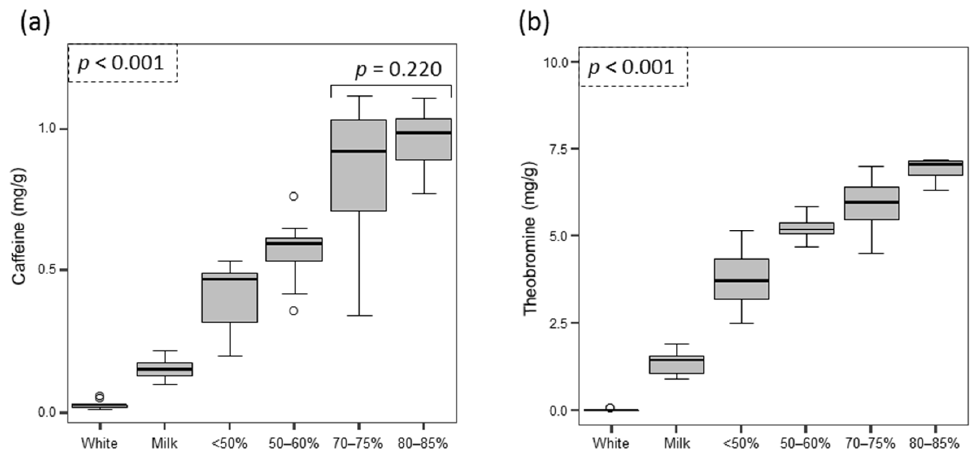
Figure 2. Box ‐ plot displaying the distribution of the concentrations (in mg/g) of caffeine ( a ) and theobromine ( b ) detected in the different types of chocolate foods analyzed. theobromine ( b ) detected in the different types of chocolate foods